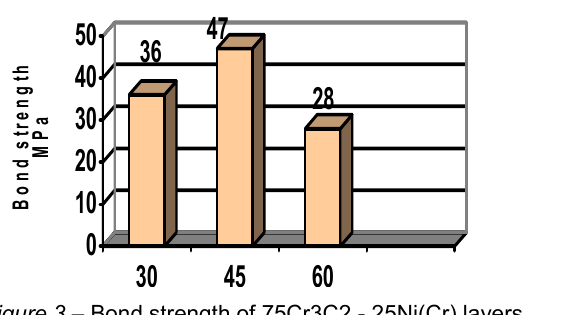
Figure 3 – Bond strength of 75Cr3C2 - 25Ni(Cr) layers Slika 3 – Č vrsto ć a spoja 75Cr3C2 - 25Ni(Cr) slojeva